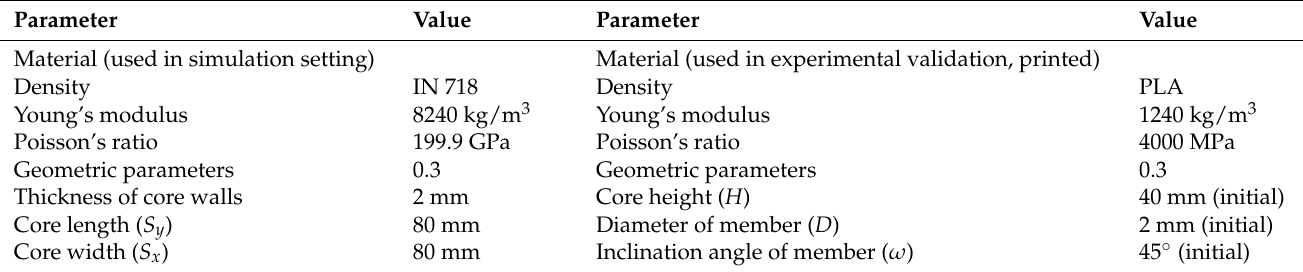
Table 1. Geometric parameters of LS core and its material information.